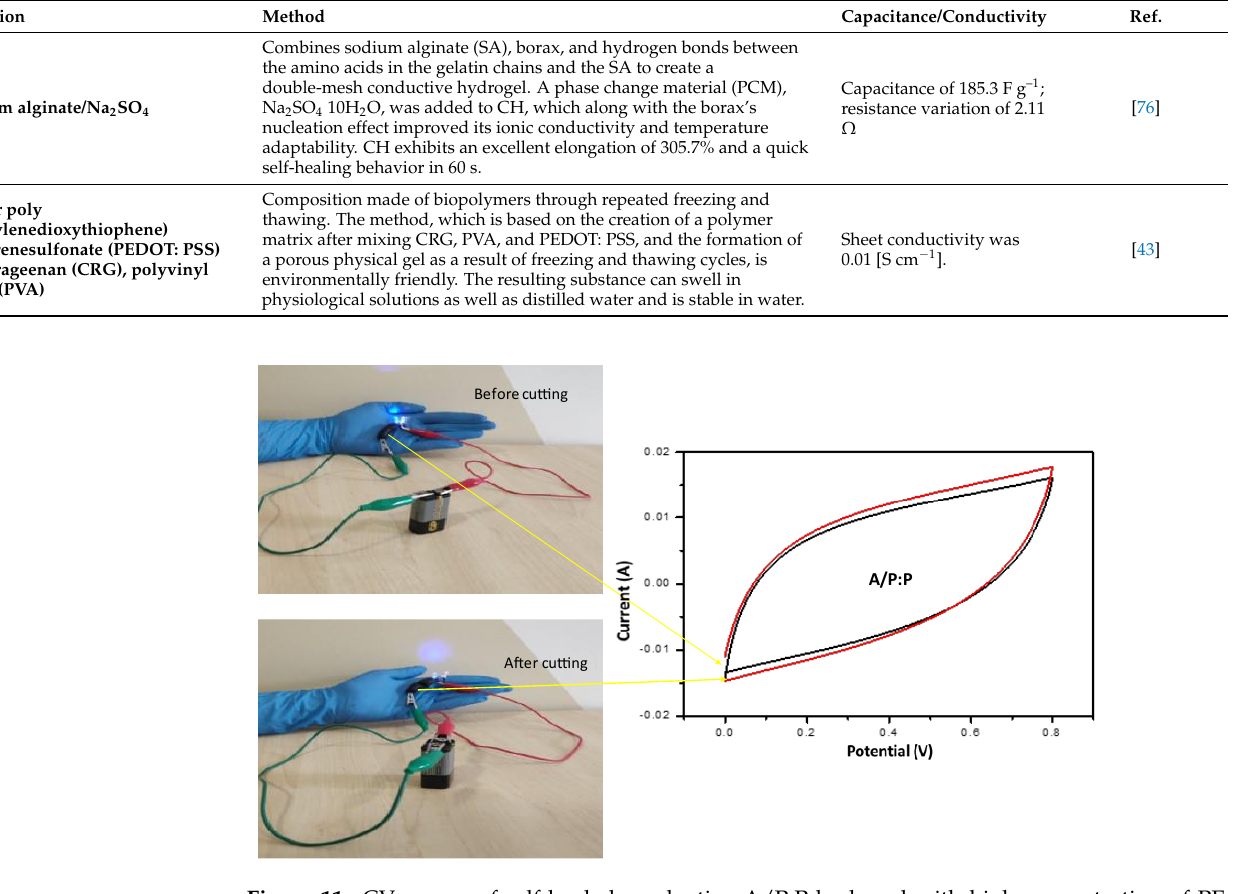
Figure 11. CV curves of self-healed conductive A/P:P hydrogel with high concentration of PE- DOT:PSS, the black curve demonstrates the stress before cutting and the red one after cutting.